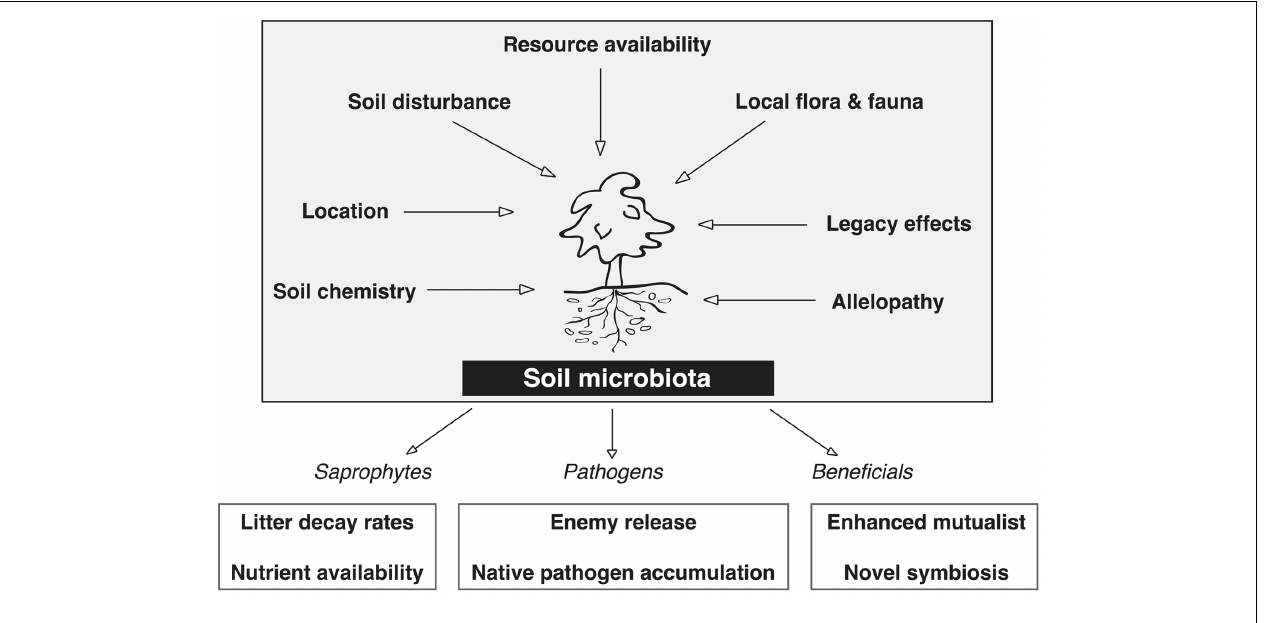
selective pressure wherein certain microbes are not capable of surviving. These seven factors dictate the relative abundance of saprophytes, pathogens, and beneficials that are able to associate with the plant.Two mechanisms of plant invasion that lead to positive feedbacks from these plant–microbe interactions are shown for each group of soil